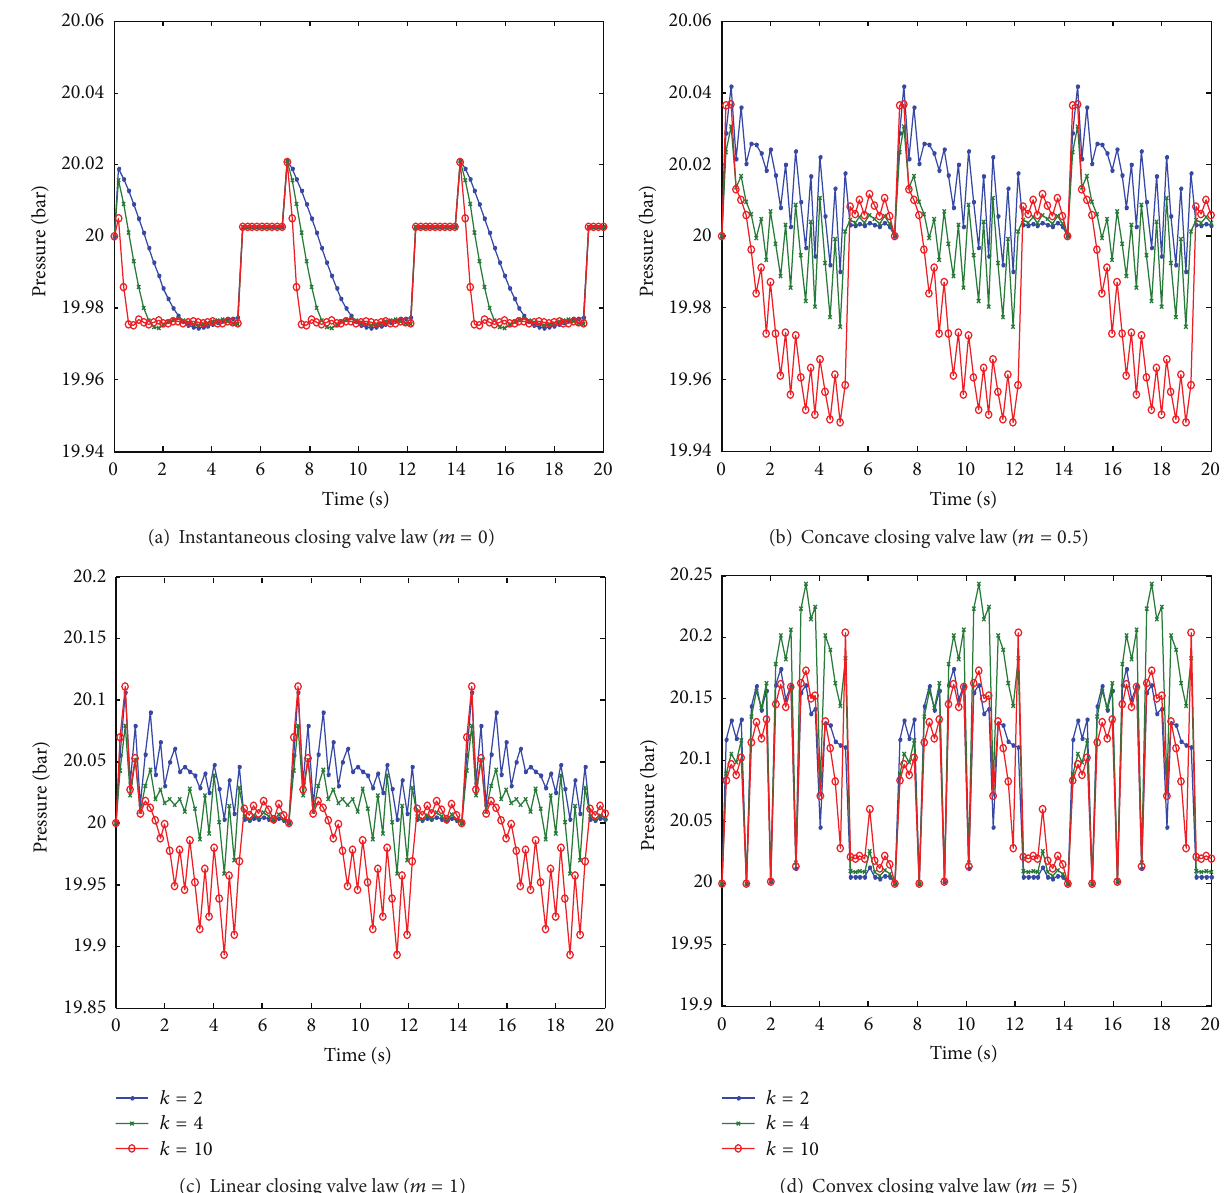
Figure 6: Transient pressure waves and their polygonal approach for different 𝑘 segments at 33% of hydrogen-natural gas